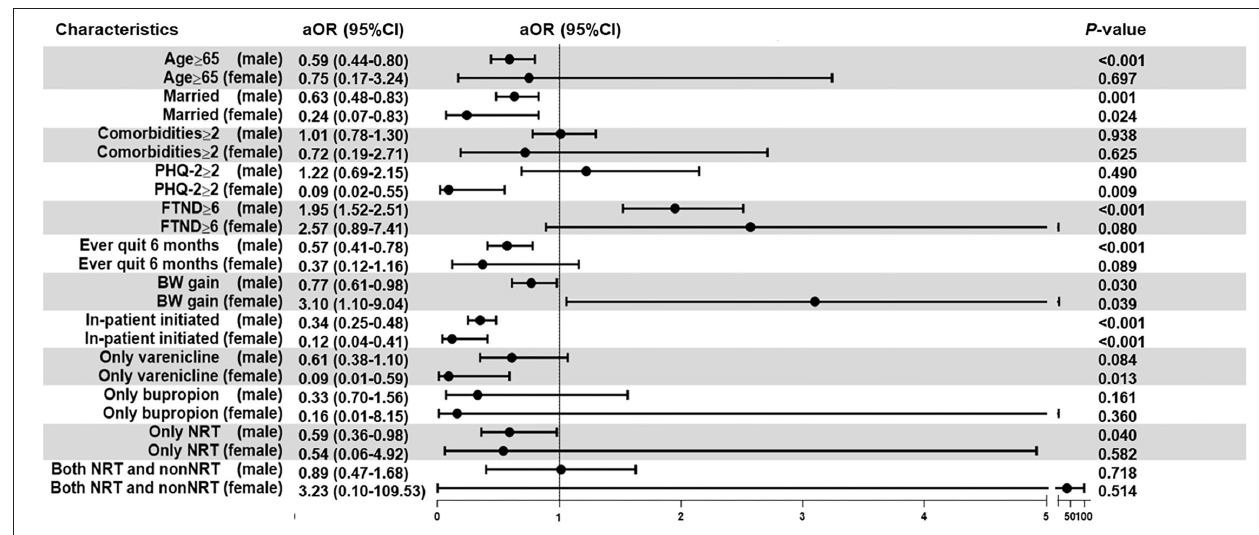
FIGURE 2 | Multivariable logistic regression following sex stratification. The analyses were adjusted for age, sex, comorbidities, PHQ-2, FTND, cessation history, BW gain, site of program initiation, and cessation medication. Firth regression analyses were used for the women subgroup. Bold values indicate a statistically significant difference with a p -value of < 0.05. aOR, adjusted odds ratio; BW, body weight; CI, confidence interval; FTND, Fagerstrom test for nicotine dependence; NRT, nicotine replacement therapy; PHQ-2, Patient Health Questionnaire-2.